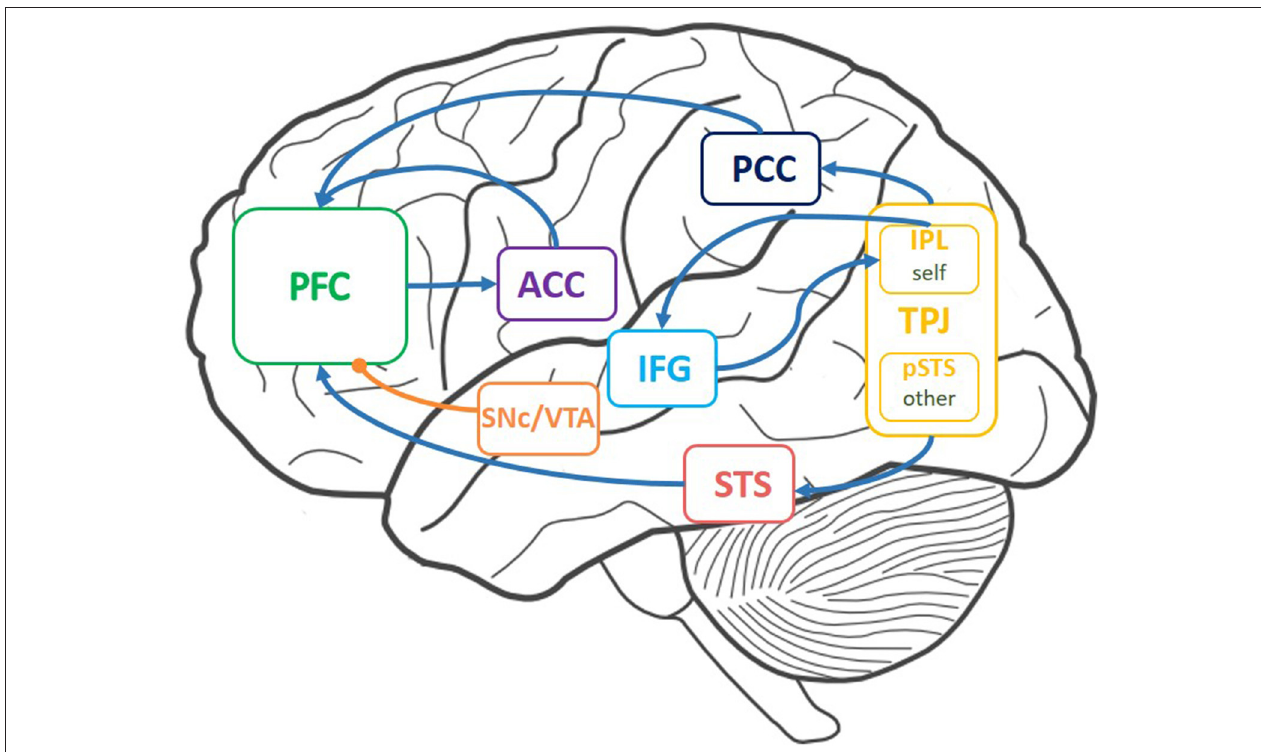
FIGURE 1 | Brain areas involved in theory of mind (ToM) and the connections between these areas. These areas include the temporo-parietal junction (TPJ), the prefrontal cortex (PFC), the anterior cingulate cortex (ACC), the inferior frontal gyrus (IFG), and the substantia nigra pars compacta/ventral tegmental area (SNc/VTA). Arrows indicate connections between brain areas. The curve with a round head represents the projection path of dopamine.